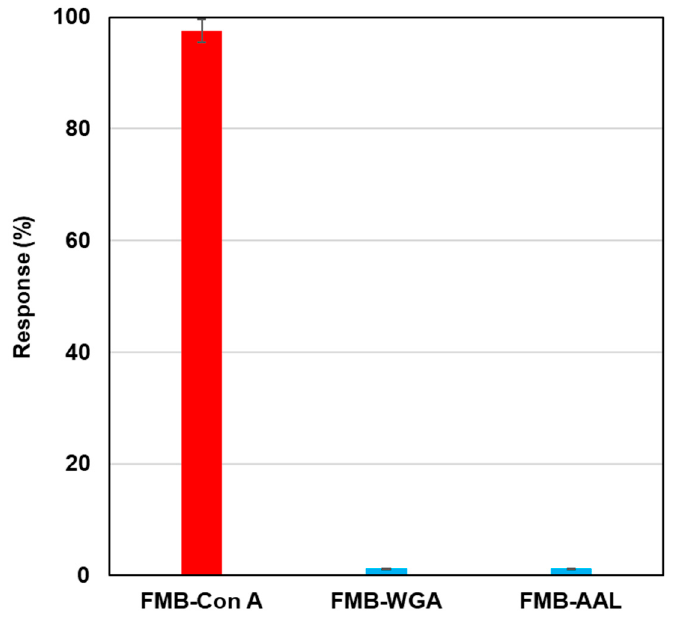
Figure 3. Fluorescence responses of FMB-Con A, FMB-WGA, and FMB-AAL after the addition of RNase-B modified using quenchers. [FMB-Con A] = [FMB-WGA] = [FMB-AAL] = 10 µ g/mL;